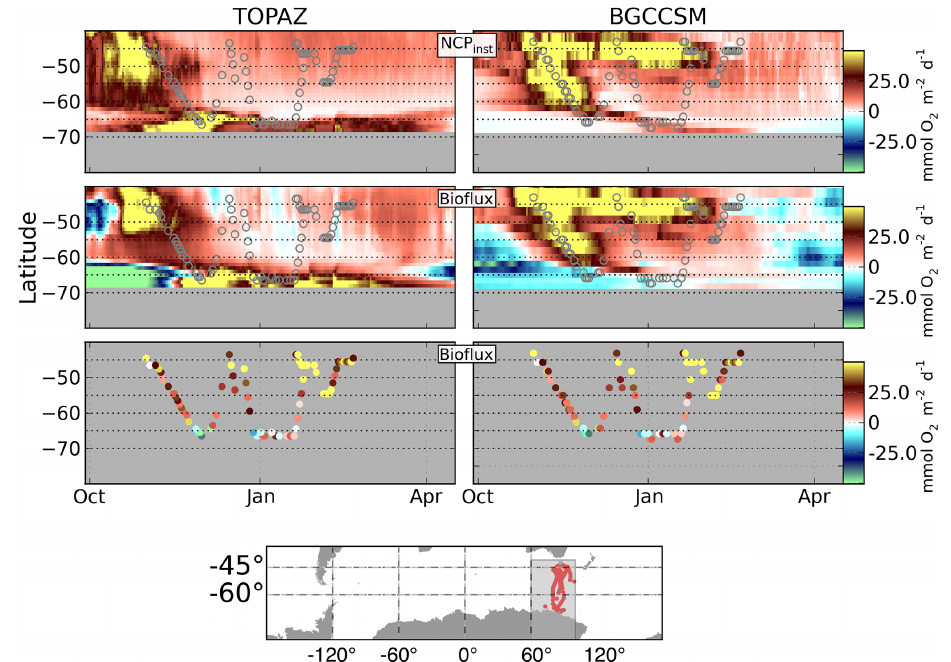
Figure 9. Hofmøller plots of model NCP (mmolm − 2 d − 1 , top panel), model O 2 bioflux (mmolm − 2 d − 1 , middle panel), and observed O 2 bioflux (mmolm − 2 d − 1 , bottom panel) in the Southern Ocean south of Australia (locations of observations are presented as red points on the map). All model values are zonal medians within the box. All observations that fall on a specific grid cell on a specific day of the year are averaged to one value.